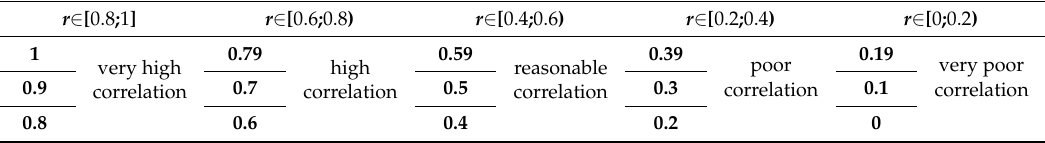
Table 4. Levels of interpretation of the Pearson correlation coefficient (r).